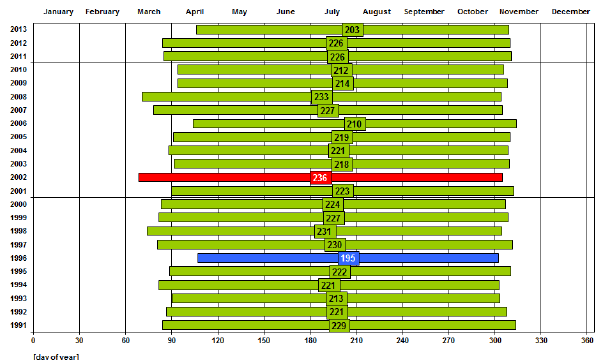
Figure 4. Growing seasons in Germany since 1991: mean begin- ning, duration (days) and ending defined by the period between “Forsythia (Forsythia suspensa) – beginning of flowering” and “Pe- dunculate Oak (Quercus robur) leaf